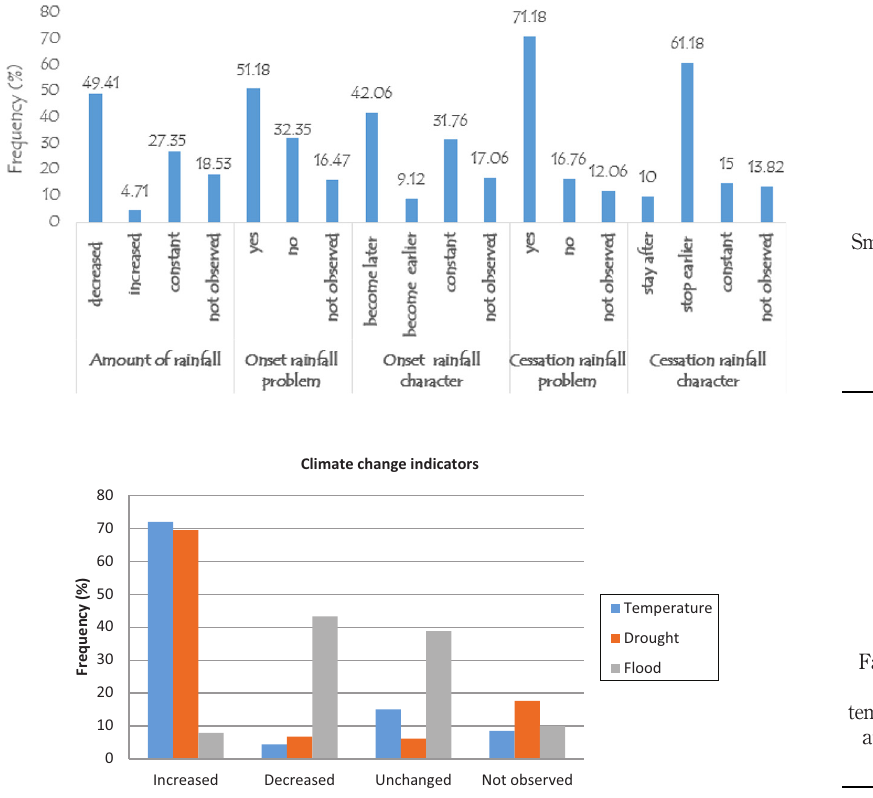
Figure 3. Farmers ’